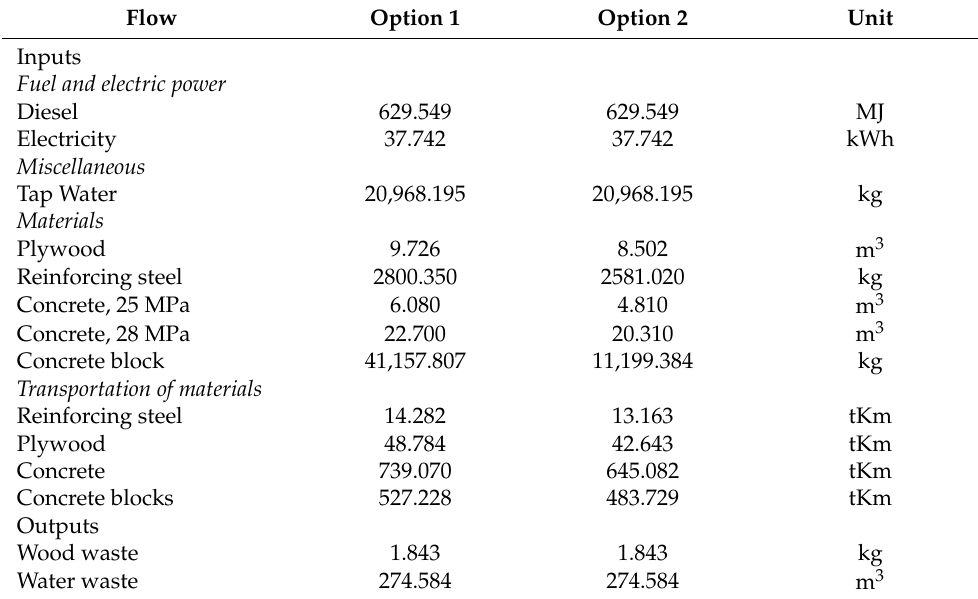
Table 5. Summary of quantities corresponding to each inflow for the functional